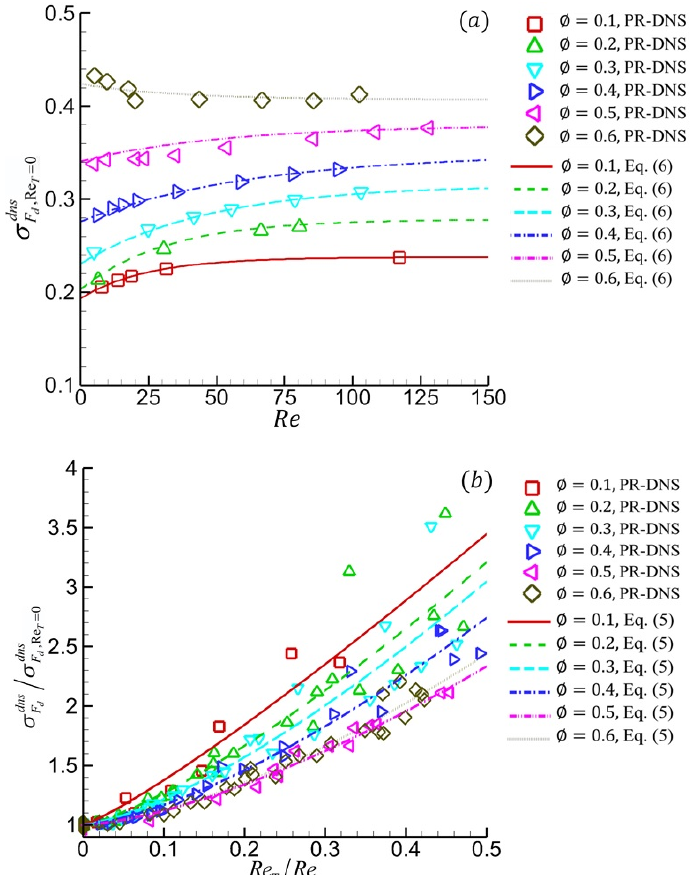
Figure 1. Comparison of the mean relative deviation of the drag forces between the particle-resolved direct numerical simulations (PR-DNSs) and fitting curves. ( a ) σ dns , 0 φ . The symbols denote PR-DNS results, and the fits of the PR-DNS results are represented by the corresponding solid lines computed by Equation (6). ( b ) σ dns / σ dns is the ratio between the mean relative deviation of the drag force at arbitrary Re T and that at Re T = 0 under the same solid volume fraction and Reynolds number. The symbols are from PR-DNS simulations, and the fits of the PR-DNS results are represented by the corresponding solid lines computed by Equation